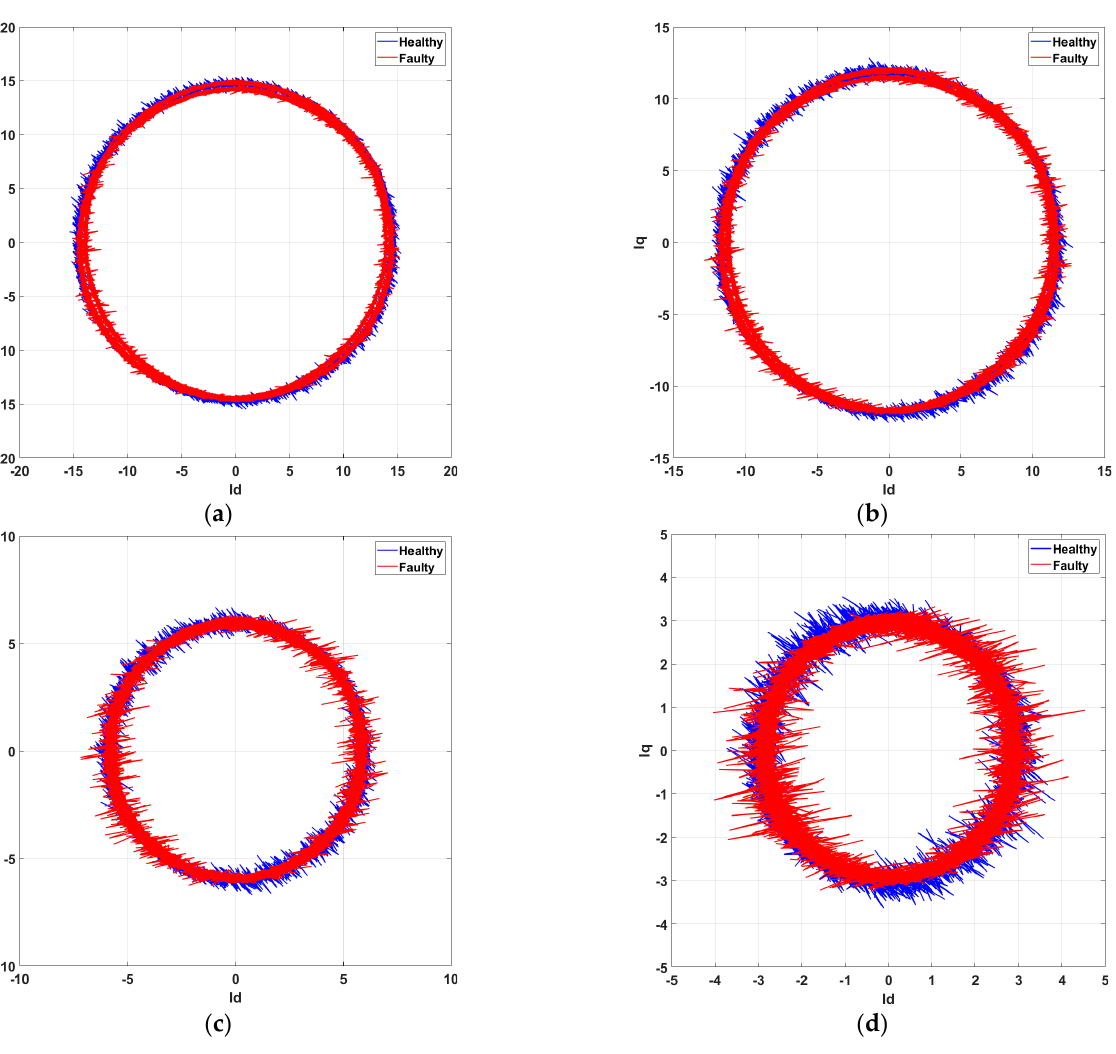
Figure A4. Experimental results. Park’s Vector of the generator at 100 rpm: ( a ) Local demagnetization 5 kW; ( b ) Local demagnetization 4 kW; ( c ) Local demagnetization 2 kW; ( d ) Local demagnetization 1